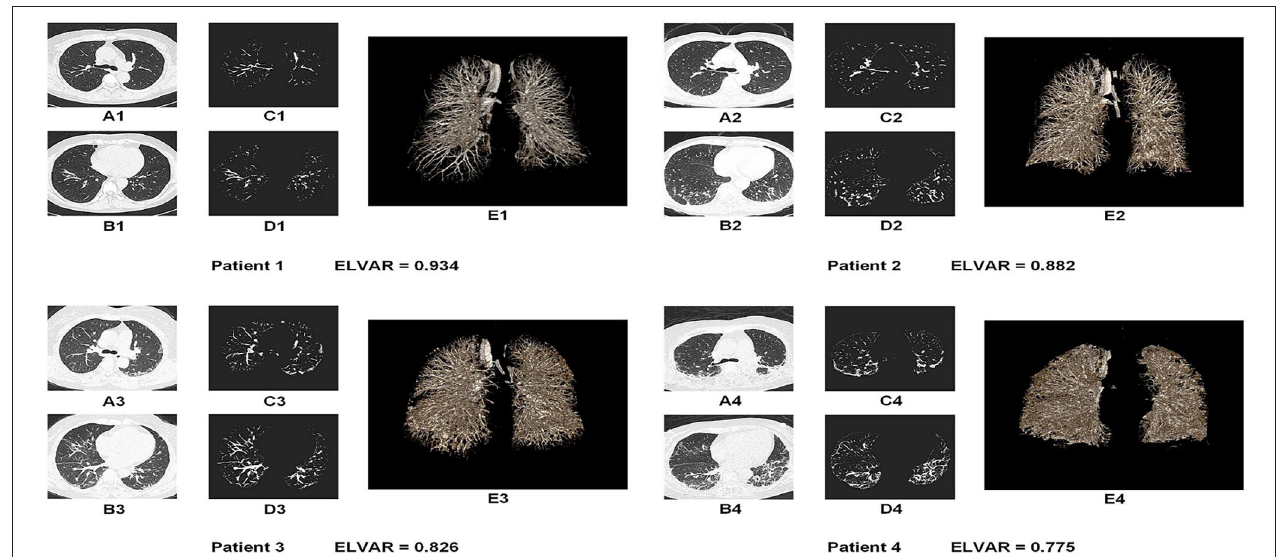
FIGURE 4 | Lung images of four MDA5 + DM patients with different value of ELVAR. (A,B) Original HRCT images in the different level of lung tissue (A was the section from bifurcation of the trachea and B was the section above the top of diaphragm); (C,D) The lung interstitial enhancement images from A and B based on computer aided analysis technique; (E) High precision three dimensional images of the lung interstitium from the same person.